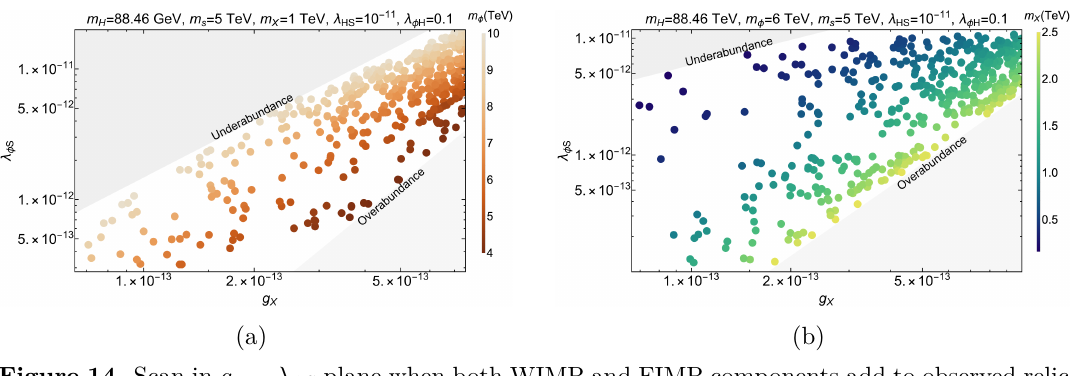
Figure 14 . Scan in g X − λ φS plane when both WIMP and FIMP components add to observed relic density, Ω X h 2 + Ω φ h 2 = 0 . 1200 ± 0 . 0012 , simultaneously addressing other constraints when